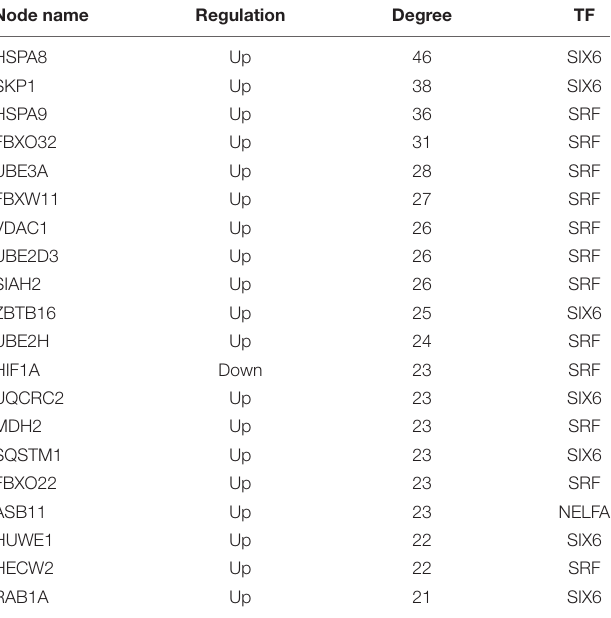
TABLE 3 | Top 20 nodes with higher degree in transcription factor–target regulatory